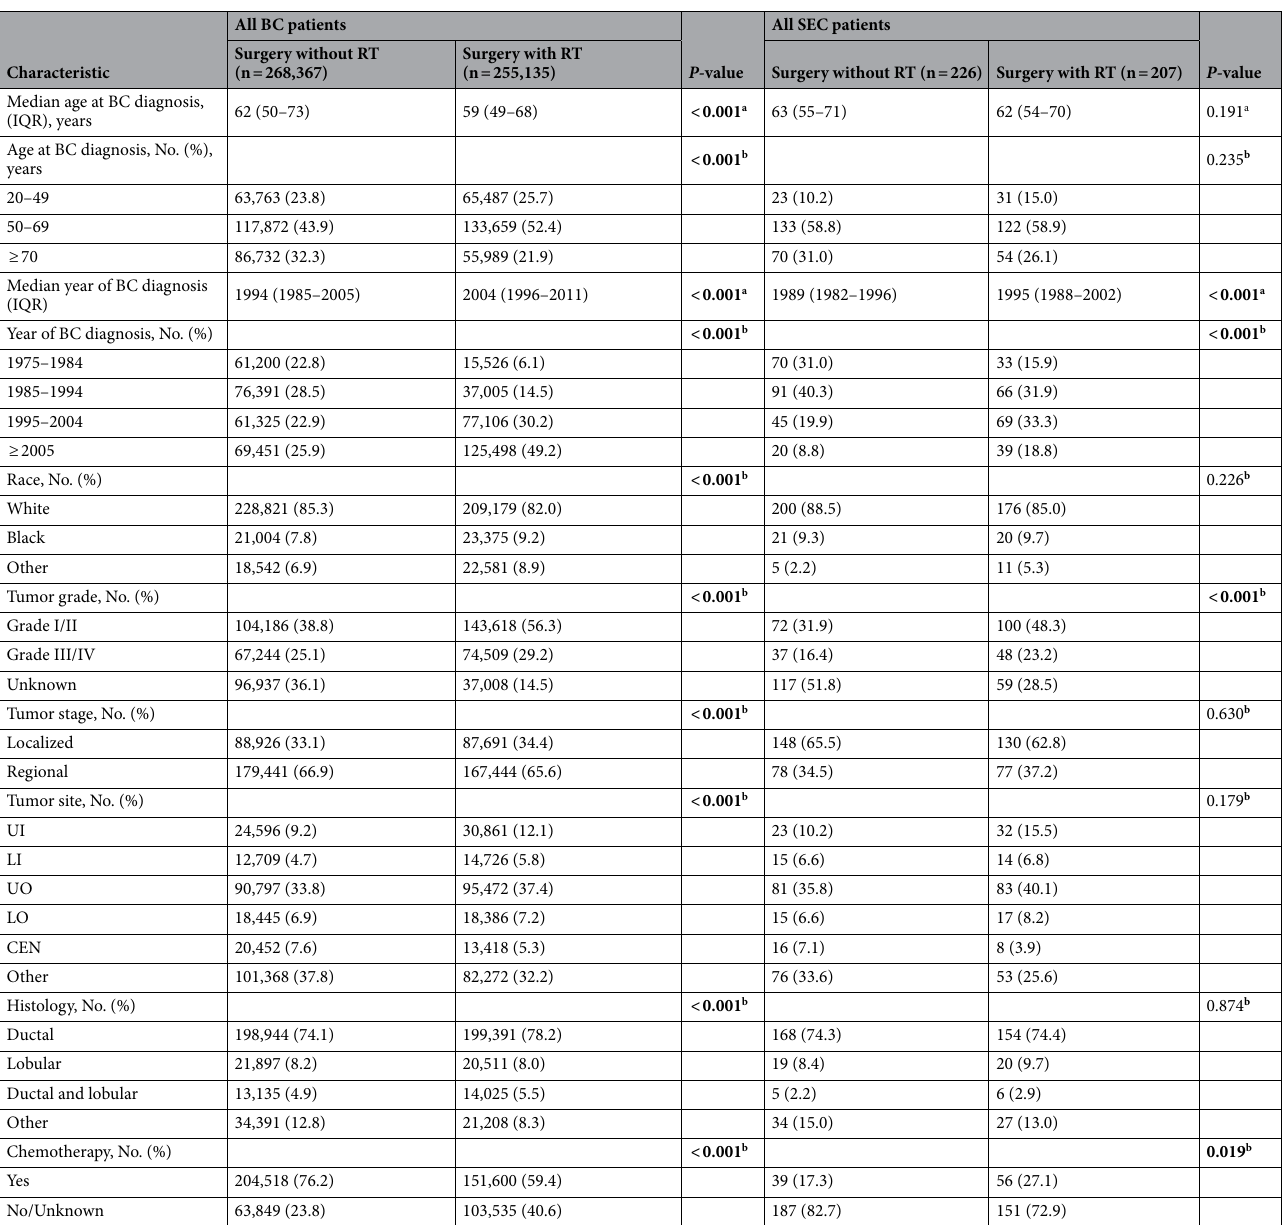
Table 2. Comparison of baseline characteristics of breast cancer (BC) patients and secondary esophageal cancer (SEC) patients receiving radiotherapy (RT) or not. P -value was calculated using the Mann–Whitney U test ( a ) for continuous variables and x 2 test ( b ) for categorical variables. IQR interquartile ratio; BC breast cancer; SEC secondary esophageal cancer; UO upper outer quadrant of breast; UI upper inner quadrant of breast; LI , lower inner quadrant of breast; LO lower outer quadrant of breast; CEN central portion quadrant of breast. The other sites of BC include axillary tail of breast and overlapping lesion of breast. Significant values are in